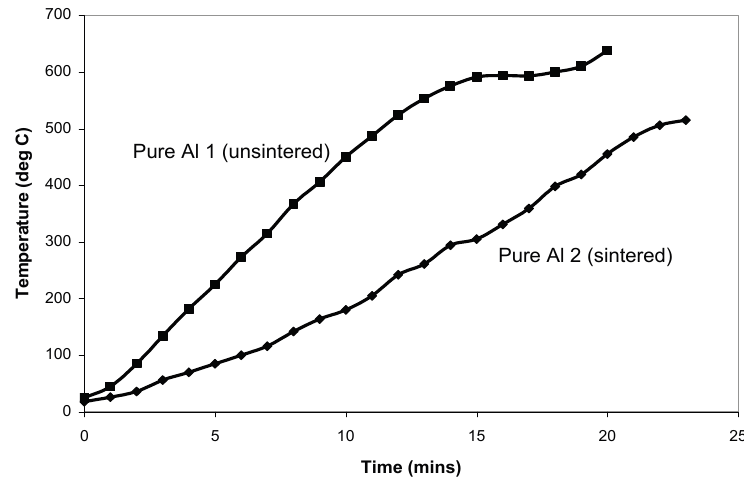
Figure 4. Differences in heating behavior between sintered and unsintered compacts [12].